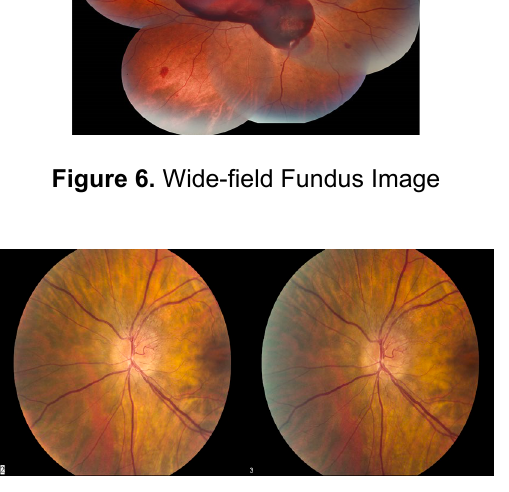
Figure 7. Stereoscopic fundus